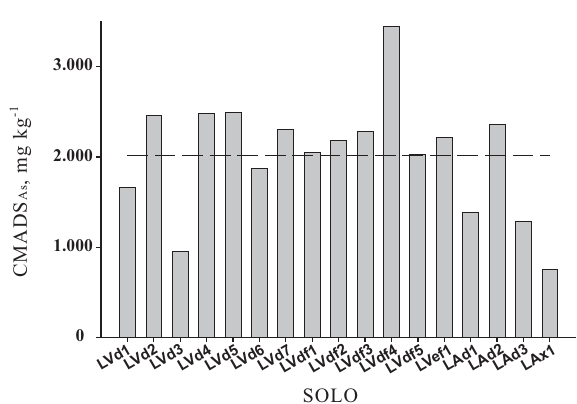
Figura 3. Capacidade máxima de adsorção de As das amostras do horizonte A dos 17 Latossolos. A CMADS foi obtida pela equação: CMADS As 1/b, sendo b a inclinação da reta obtida por regressão linear (Figura